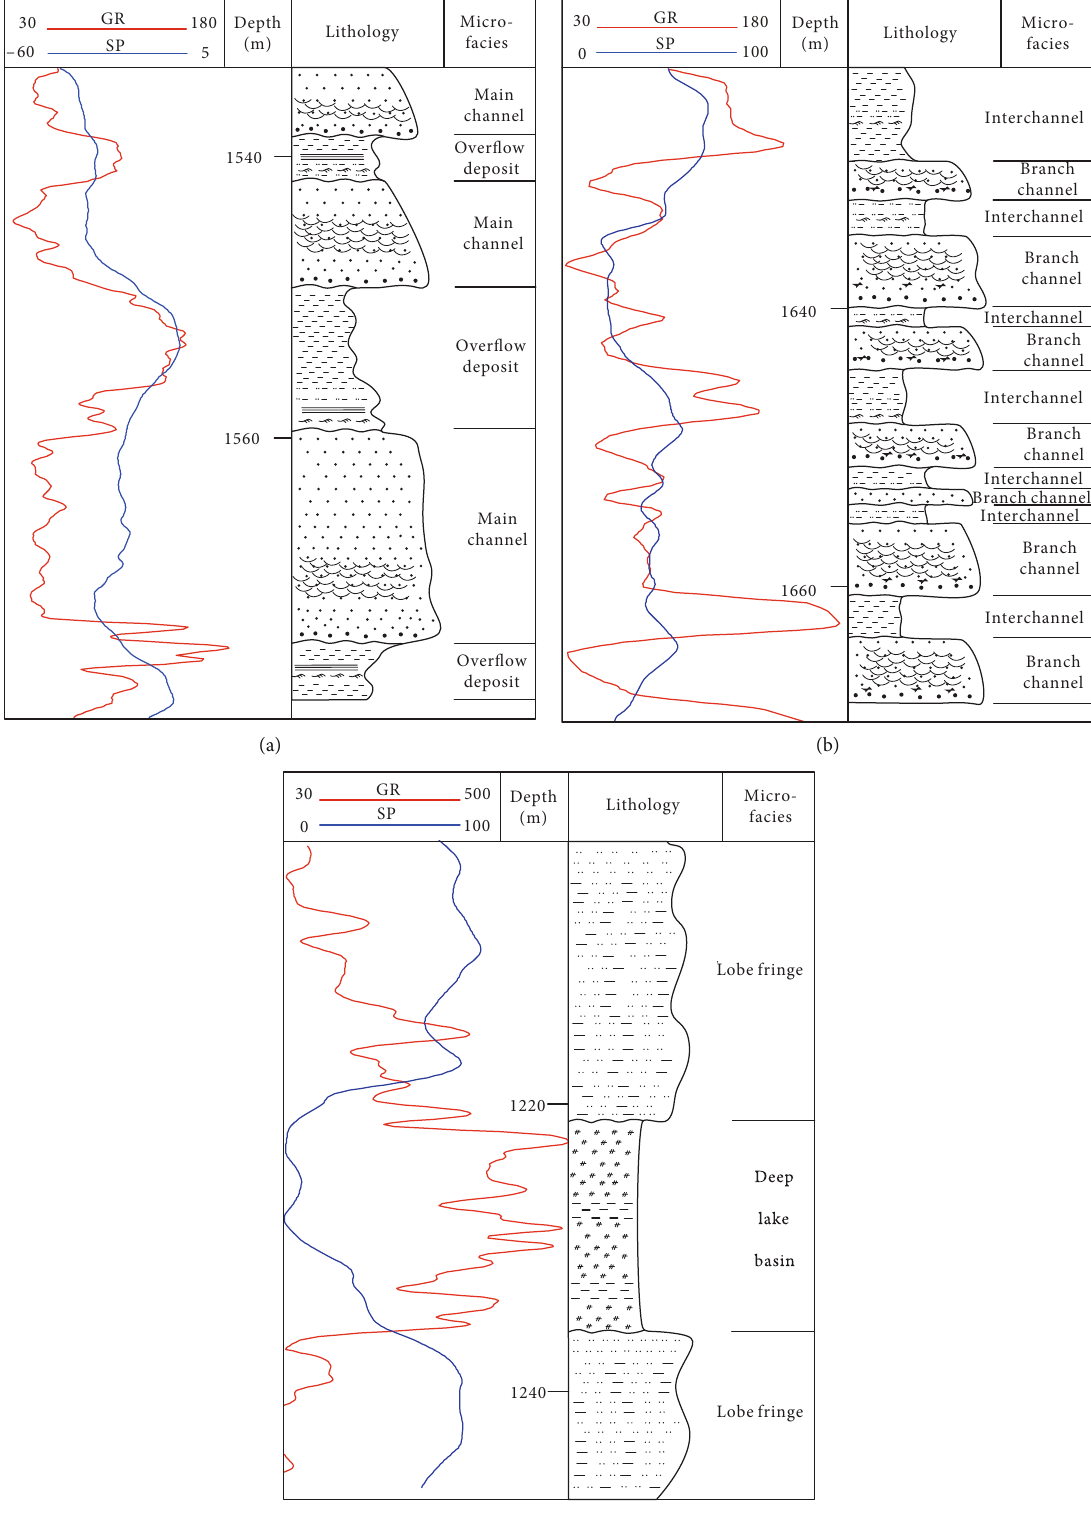
Figure 7: Characteristics of logging curves in di ff erent sedimentary facies: (a) logging curve characteristics of main channel fi lling deposits; (b) logging curve characteristics of branch channel fi lling deposits; (c) logging curve characteristics of lobe